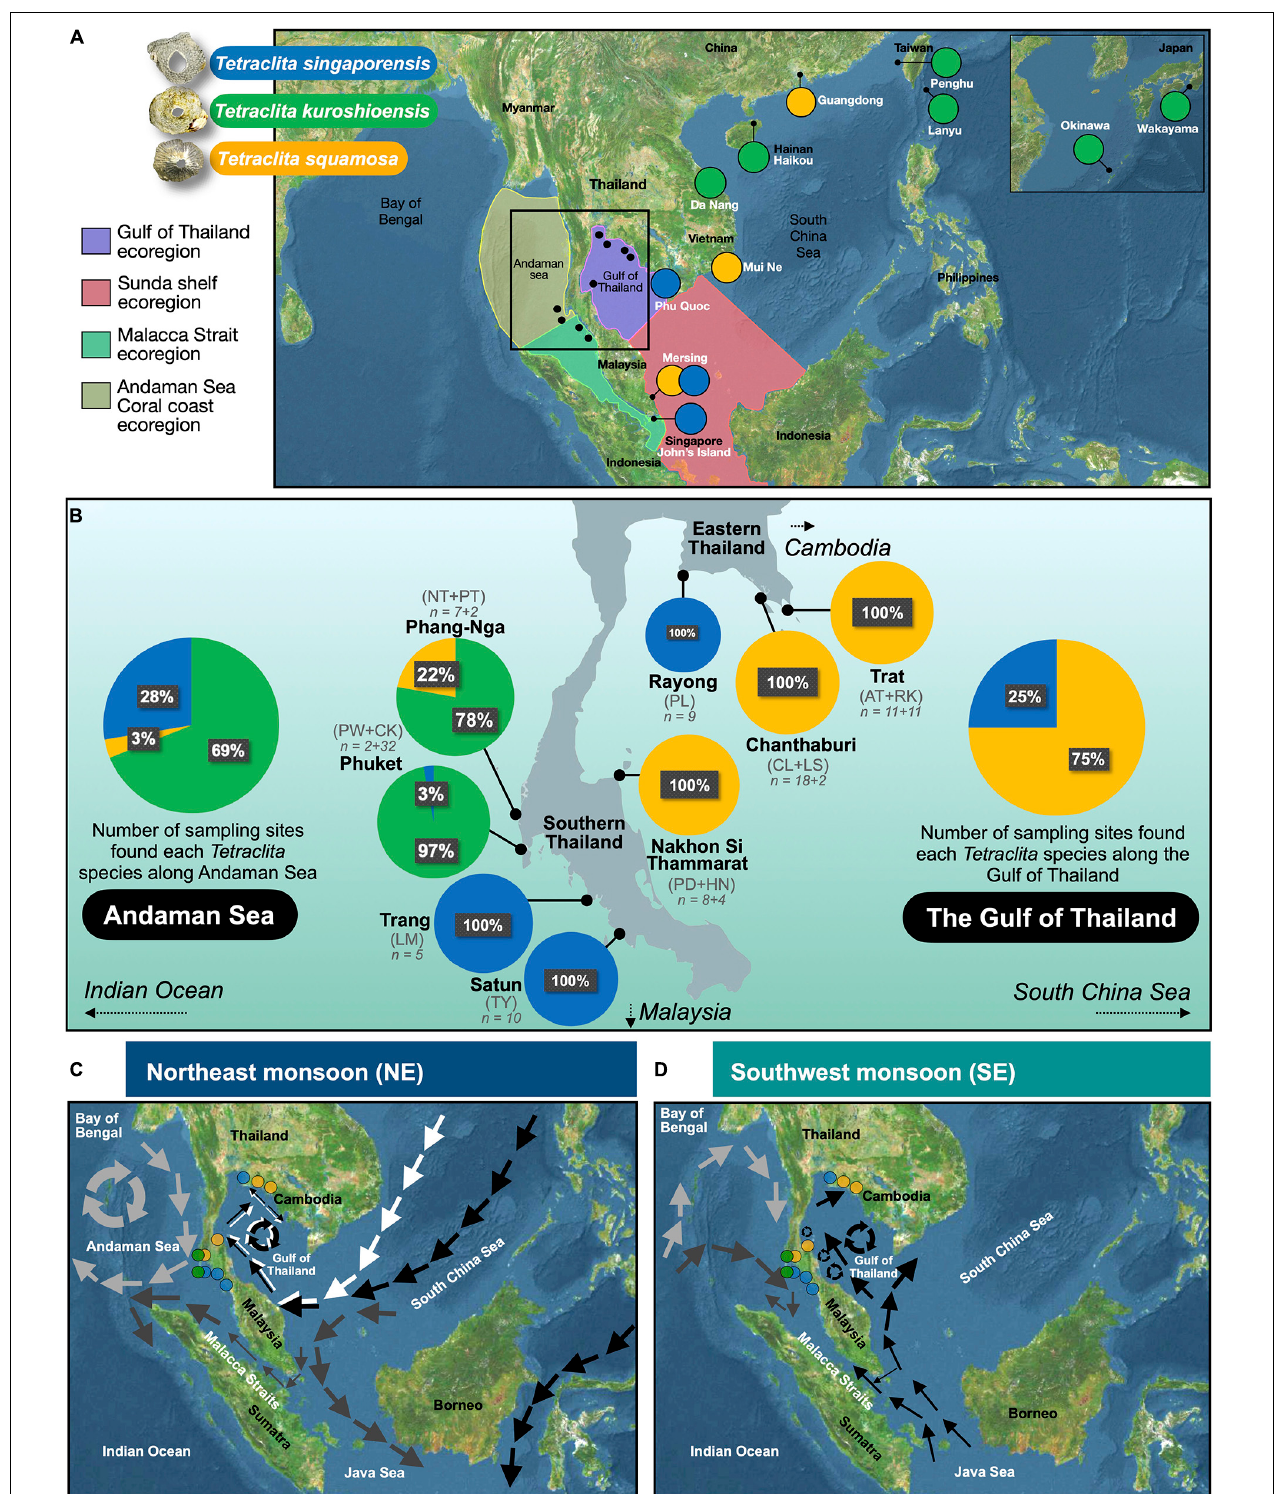
FIGURE 1 | (A) Sampling sites in the Gulf of Thailand and Andaman Sea of Thailand waters (represented by black dots in the rectangle, which are magnified in B ). The dots outside the rectangle represents locations of Tetraclita sequences obtained from Genbank and used in the present study. (B) Sampling site of Tetraclita spp. in the present study and the relative percentage of Tetraclita spp. in each site. (C) Oceanographic currents in the South China Sea and Andaman Sea in the